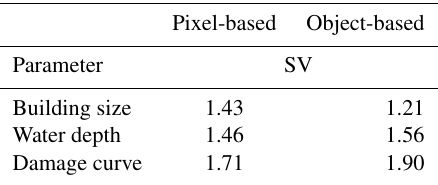
Table 8. The sensitivity values (SVs) of the different damage pa- rameters for the pixel- and object-based